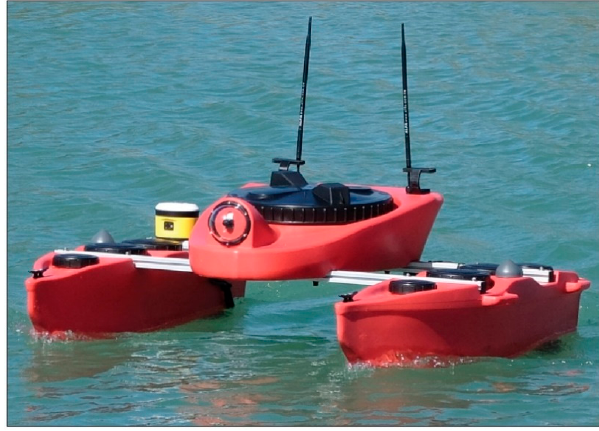
Figure 1. An OpenSWAP vehicle during a test